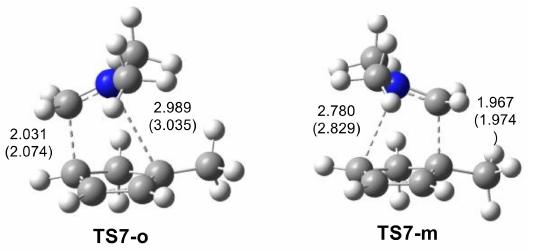
Figure 7. ω B97XD/6-311G(d,p) geometries of two regioisomeric TSs for I-DA reaction of iminium cation 6 with CpMe 20 . The distances are given in Angstroms. The gas phase distances are given in parentheses.